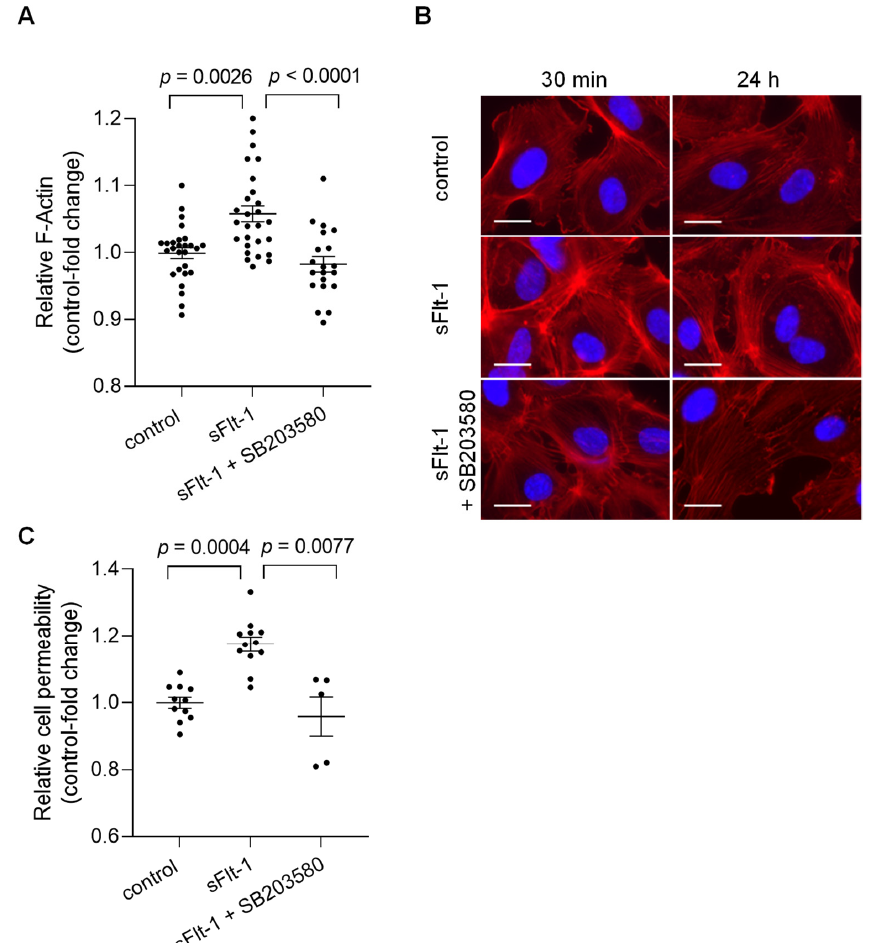
Figure 3. Excess sFlt-1 affects the actin cytoskeleton and disturbs the endothelial barrier function. Primary HUVECs were treated with sFlt-1 or control protein (2 µ g/mL) for 24 h in the presence or not of SB203580 (10 µ M). ( A ) F-actin was quantitatively assessed by measuring phalloidin fluorescence intensity using a microplate reader. ( B ) Changes in F-actin distribution in cells treated with sFlt-1 for 30 min and 24 h were assessed by immunofluorescence microscopy. Scare bar = 20 µ m ( C ) Endothelial cell permeability, as a measure of barrier function, was determined by the passage of streptavidin-HRP through the endothelial monolayer seeded on transwell units (0.4 µ m pore). Data are given as fold-change relative to control and expressed as mean ± SEM. HRP, horseradish peroxidase; SB203580, specific p38 MAPK inhibitor.